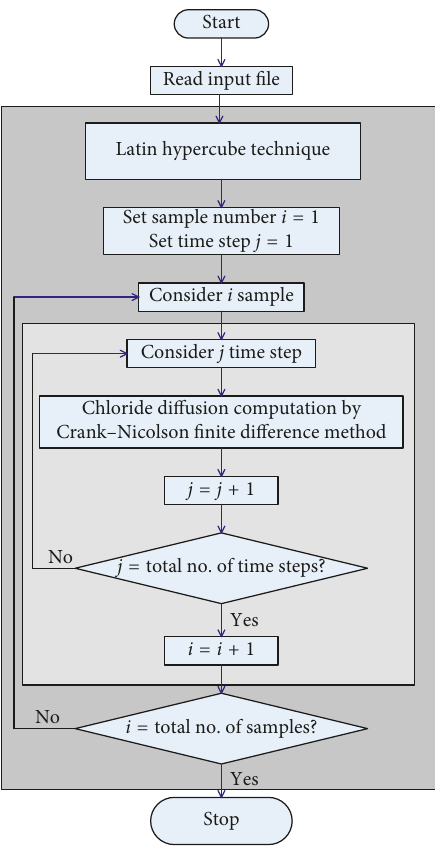
Figure 1: Flowchart for the developed